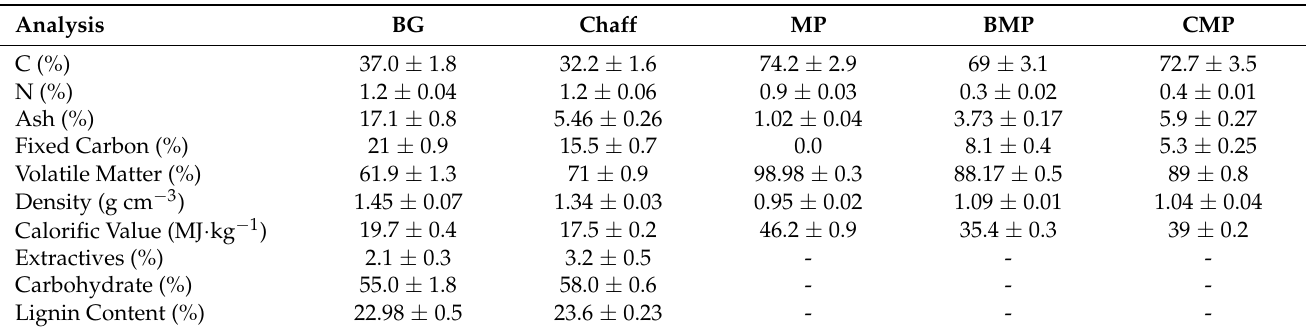
Table 1. Proximate and ultimate analyses, density, calorific values, and chemical content of bluegrass (BG), chaff, mixed plastic (MP), BMP, and CMP.